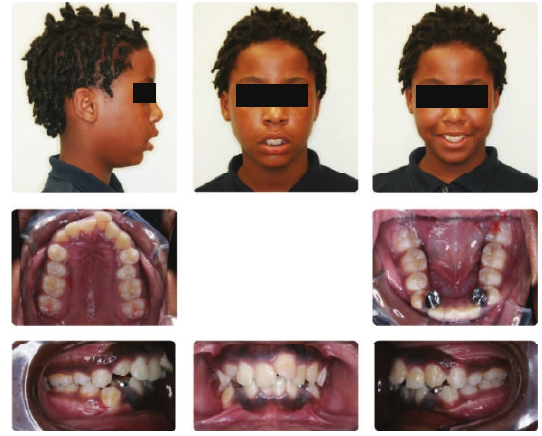
Figure 1: Initial composite.